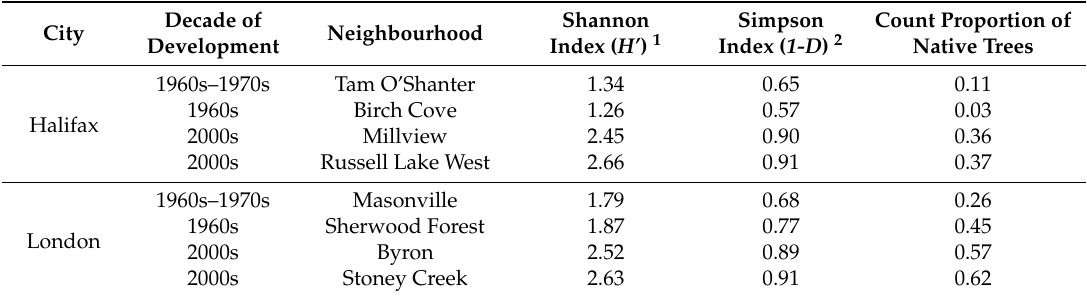
Table 4. Diversity indices of street tree communities combined according to neighbourhood.